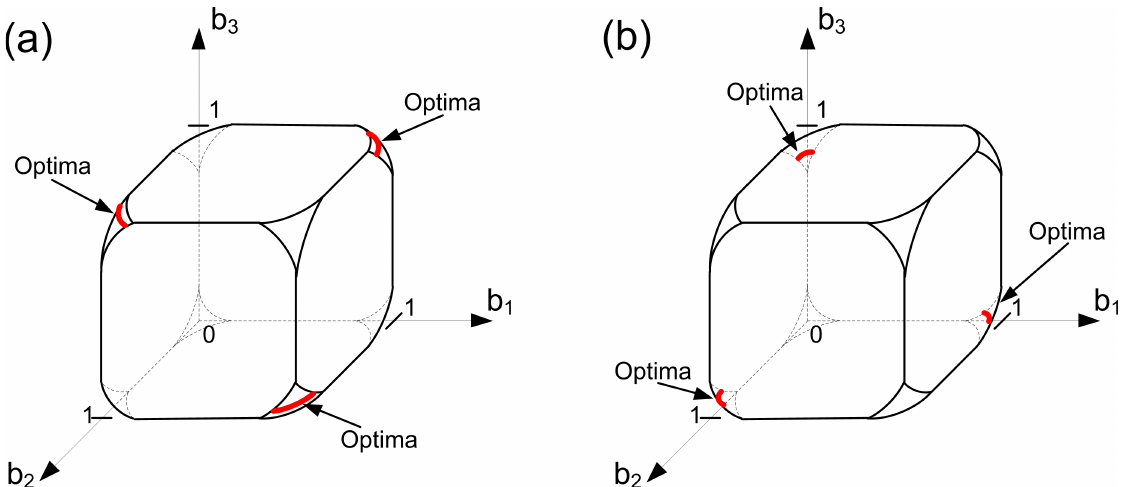
Fig 2. Evolution of germ and soma in colonies with identical cells: A convex trade-off, a resource constraint and different ‘importances’ of viability and fecundity (Case 2). Here we assume that we have three groups of cells within the colony such that all cells from each group have the same level of fecundity and the same level of viability (i.e., we have three ‘aggregate’ cells in the colony). Optimal strategies of the colony are colored in red. The level of specialization in soma and germ within the set A depends on the relative ‘importance’ of fecundity to viability. In both panels, k 1 = k 2 = 1, α = 1, C = 2.85 and φ = ( b- 1) 2 . In panel (a), β = 0.5. In panel (b), β = 2.